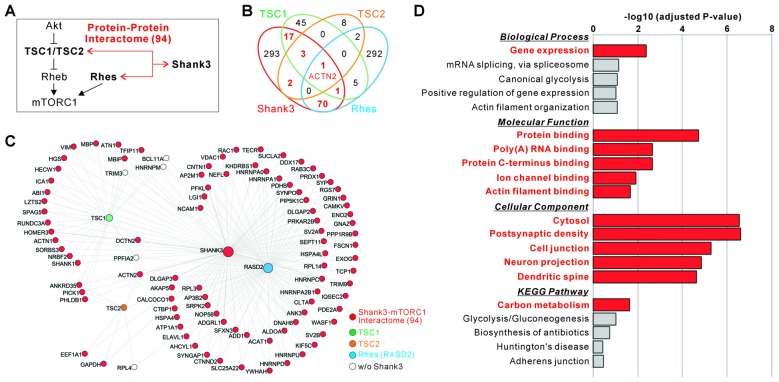
Protein interaction-mediated connectivity between Shank3 and upstream regulators of mTORC1. (A) The diagram shows a summary of protein interaction-mediated connectivity between Shank3 and the upstream regulators of mTORC1 (tuberous sclerosis 1, TSC1/TSC2 and Ras homolog enriched in striatum, Rhes). (B) The Venn diagram shows the number of interactors shared by Shank3, TSC1, TSC2 and Rhes proteins. The actin filament bundling protein, α-actinin 2 (ACTN2), is the only common interactor for all four proteins. (C) The interactome network of Shank3, TSC1/TSC2 and Rhes. To simplify the network, the orphan nodes, defined as nodes connected with only one of the hub proteins (Shank3, TSC1/TSC2 and Rhes), are excluded from the graphics. The nodes for 94 proteins of Shank3-mTORC1 interactome are colored in red. The complete list of interactomes for Shank3, TSC1, TSC2 and Rhes is provided in Supplementary Table S6. (D) Gene ontology (GO) and kyoto encyclopedia of genes and genomes (KEGG) pathway analyses of the 94 proteins of Shank3-mTORC1 interactome. Significant terms (Benjamini adjusted P value < 0.05) are in bold red. The complete list of analyses is provided in Supplementary Table S7.